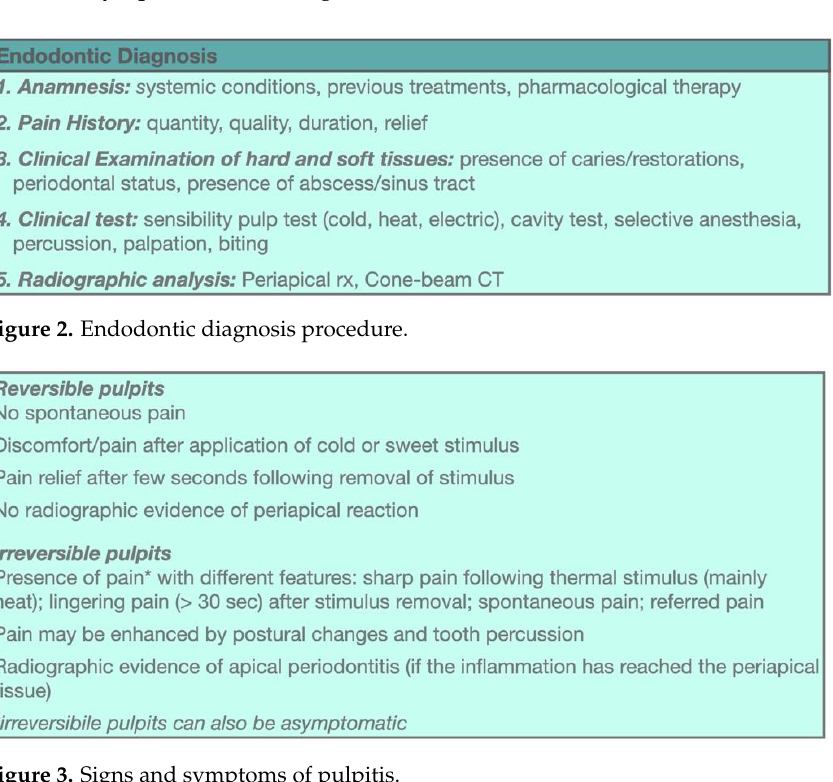
Figure 3. Signs and symptoms of pulpitis.